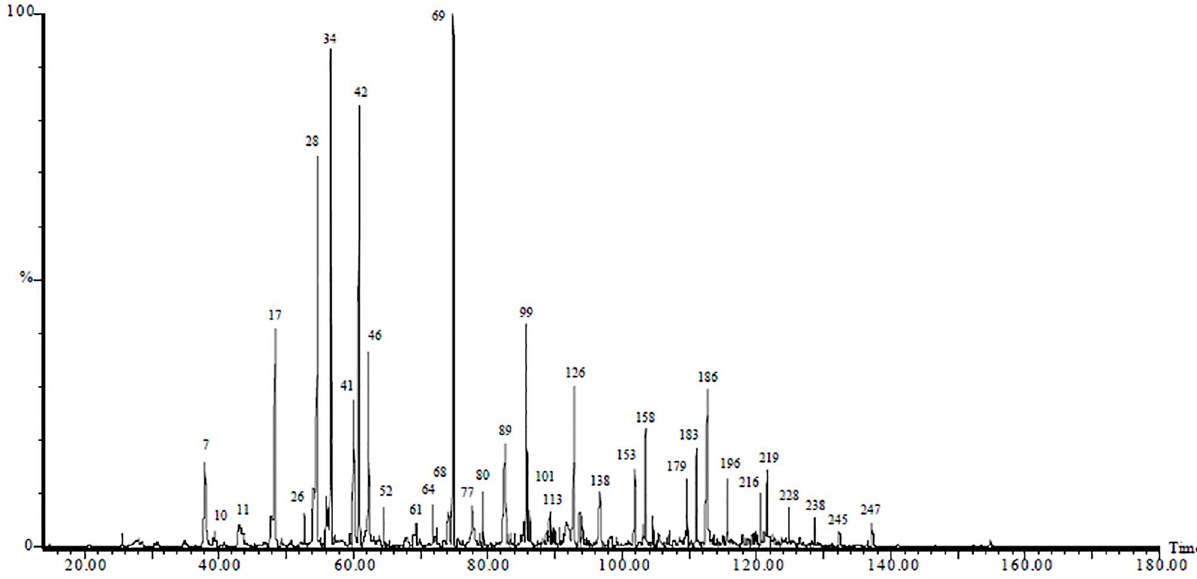
Fig 2. GC profile of most attractive human foot odor. The numbers represent individual peaks in the foot odour as they get eluted from the GC column; Peak 69 is geranylacetone and major component but not bioactive, while peak 10 n-octanal , 17 ( n- decanal), 34 ( n -decanal), 42 (4-ethylacetophenone), 52 ( n -undecanal) and 77 ( n -dodecanal) are bioactive among the other electro-physiologically active ones that are too tiny to be labelled.